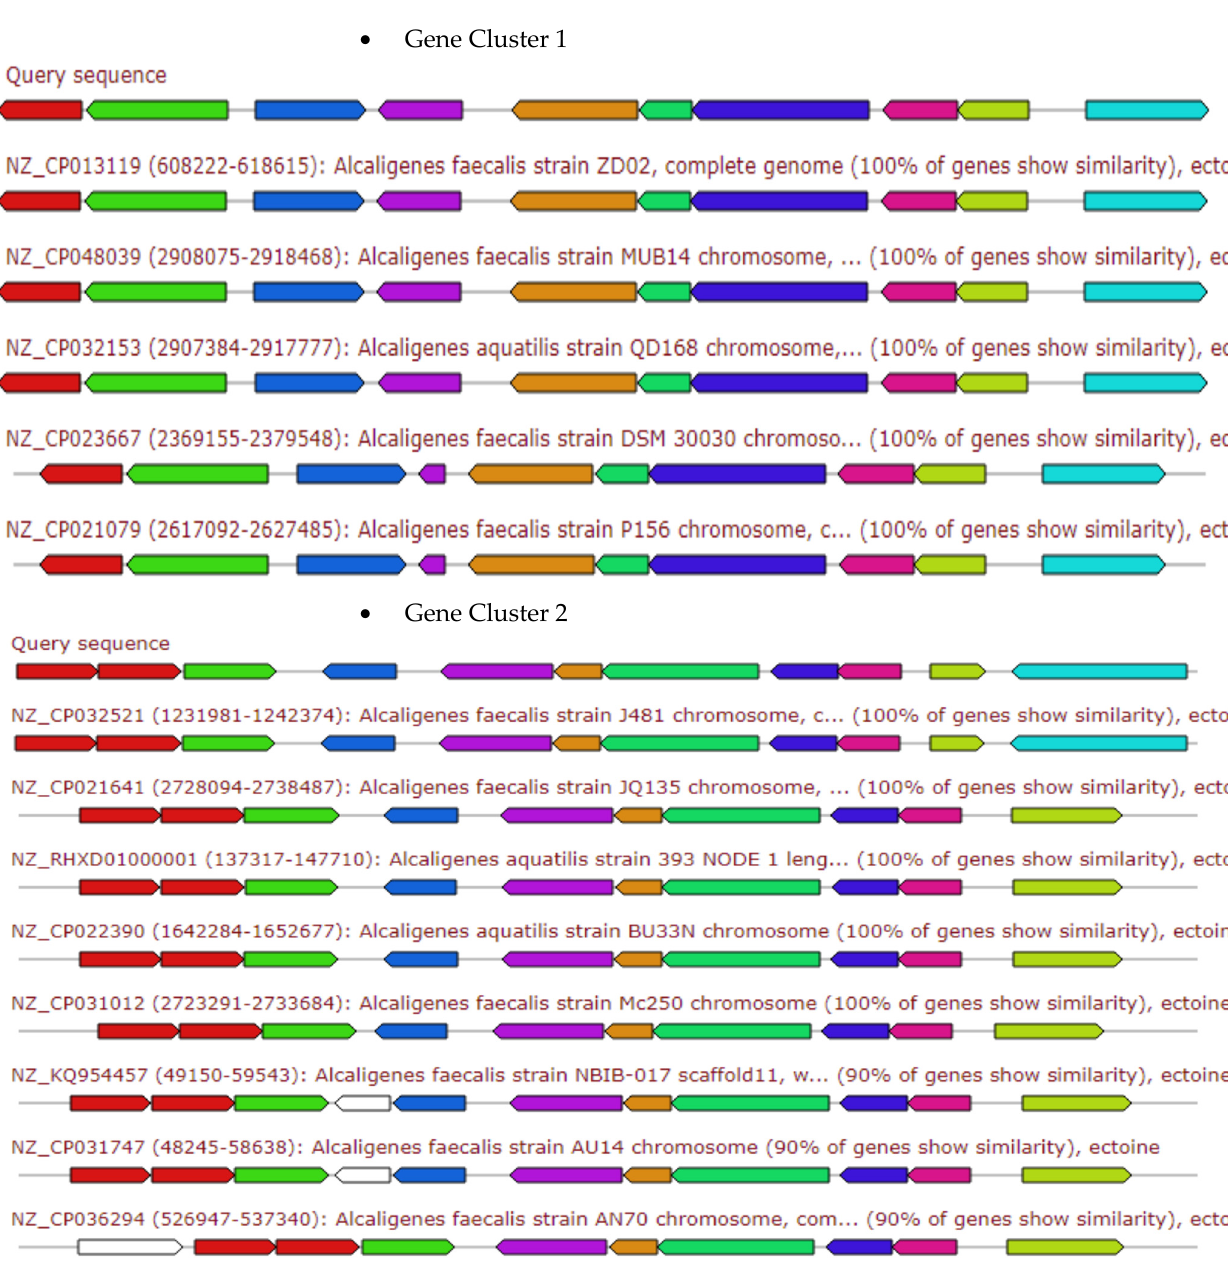
Figure 3. Gene arrangement of top 13 ectoine gene clusters (presented in gene cluster 1 and 2 as compared to the query sequence of A. faecalis isolate MZ921504. The putative biosynthetic genes presented in red, additional biosynthetic genes in orange, transport-related genes in blue, regulation-related genes in green color, resistance genes in pink, TTA codon in dark pink and grey represent other genes.